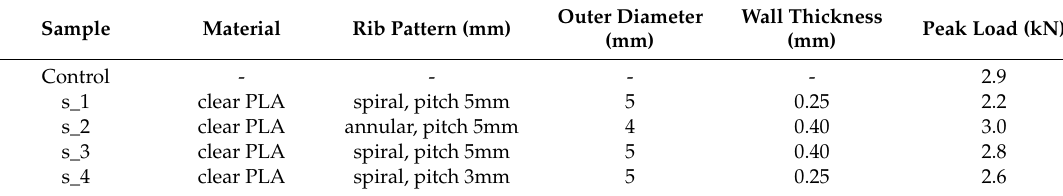
Table A3. Three-point bend test results of mortar samples containing